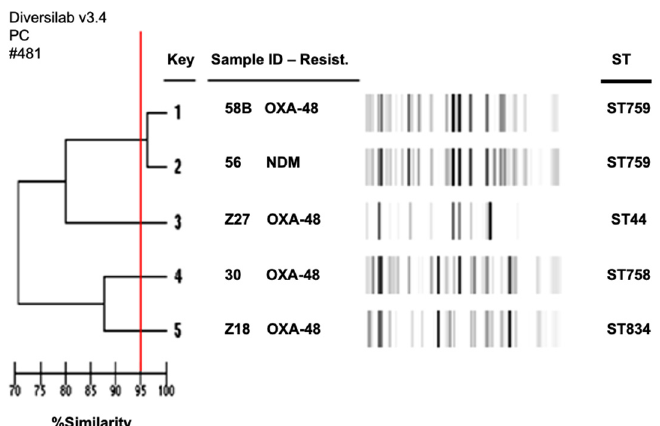
Figure 2. Dendrogram of NDM-1- and OXA-48-producing Escherichia coli isolates. Red line corre- sponds to the limit of the clonality recommended by the manufacturer.